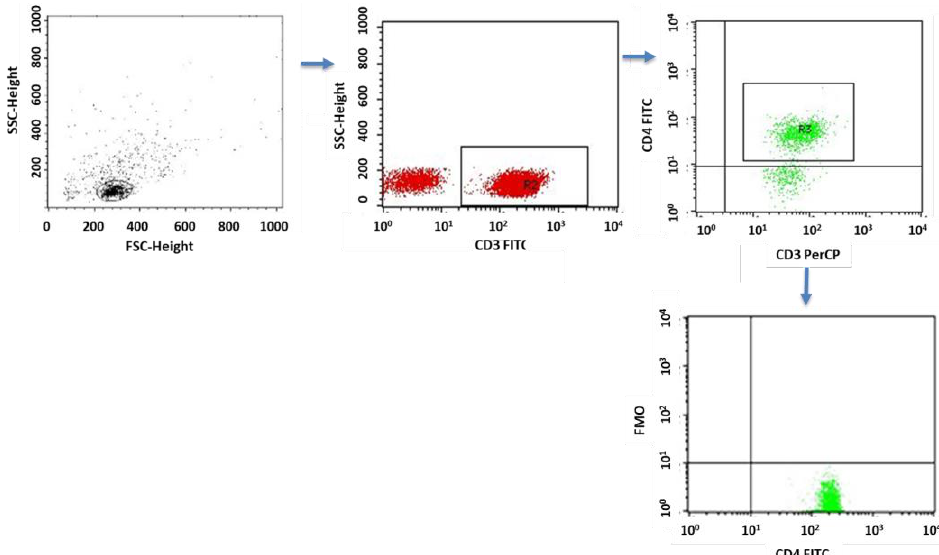
Figure 14. FMO control for cytometric analyses of cytokines.